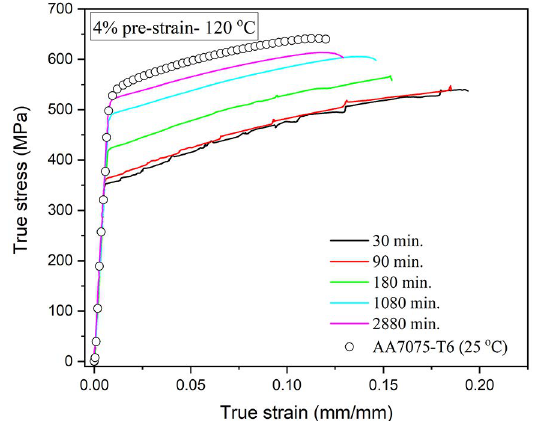
Figure 12. True stress vs. true strain for different aging time at 120 ºC (4%